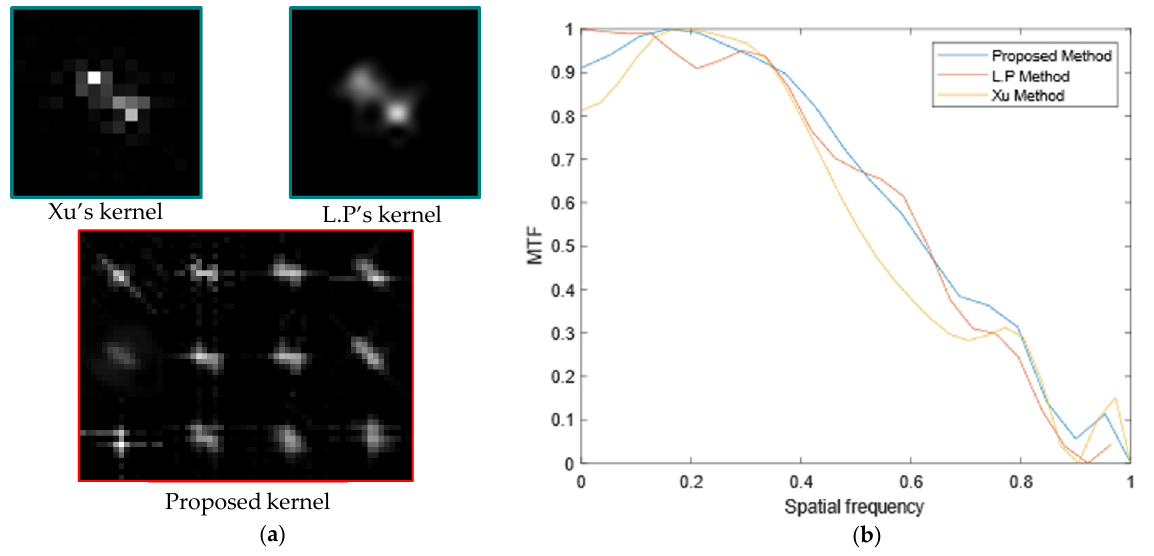
Figure 11. ( a ) The kernels from Xu’s, L.P’s and the proposed method. The kernel results of the comparison